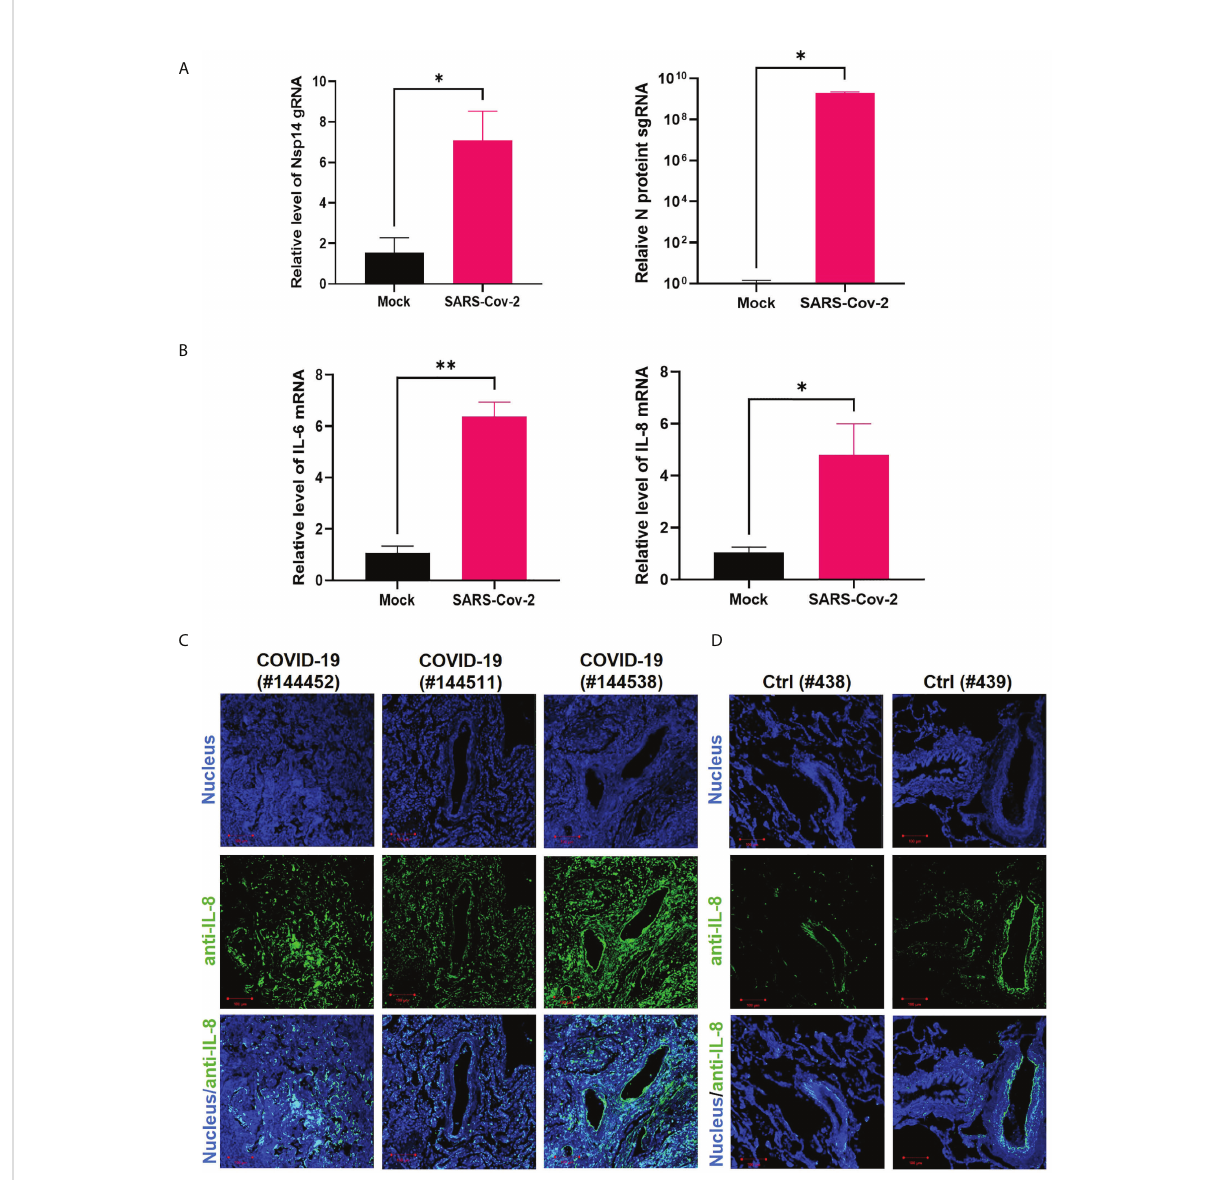
FIGURE 3 IL-8 is induced by Nsp14 and in SARS-CoV-2 infected lung tissues. (A, B) HEK293T-ACE2 cells were infected with wild-type SARS-Cov-2 viruses. Cells were harvested at 24 h. Total RNAs were extracted, and the expression of viral genes (Nsp14, N-protein, A ) or cytokines (IL-6, IL-8, B ) was analyzed by RT-qPCR and normalized to mock infection. Results were calculated from 3 technical repeats and presented as mean +/- standard error of the mean (SEM). (* p<0.05; ** p<0.01; by unpaired Student ’ s t-test). (C, D) Dissected lung tissues from COVID19 patients ( C , donors #144452, #144511, #144538) or non-infected donors ( D , donors #438, #439) were analyzed for IL-8 expression by immuno fl uorescence (green). Nuclei were stained with Hoechst (blue). Scale bar: 100